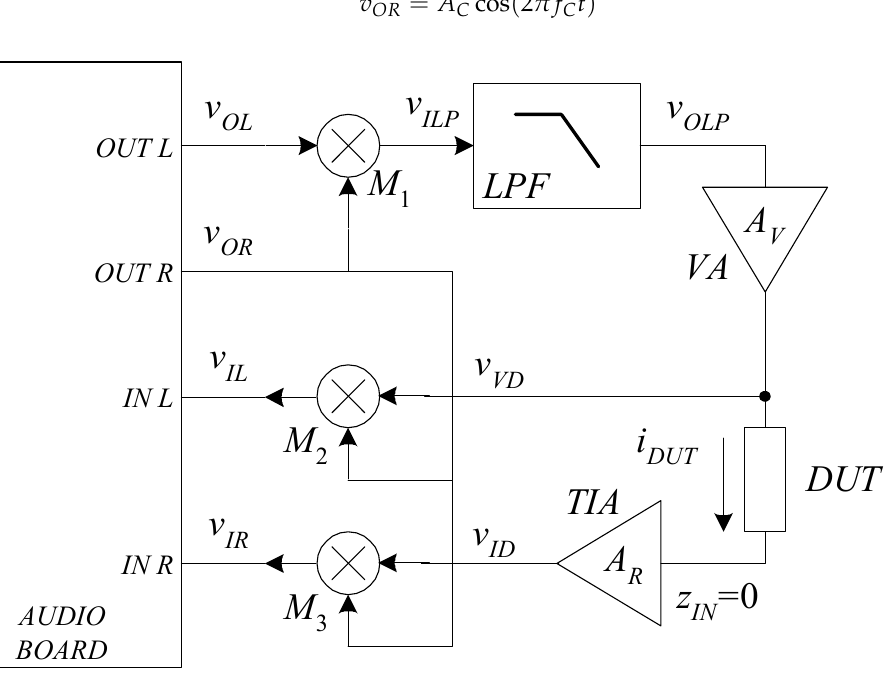
Figure 1. Block diagram of the proposed approach.